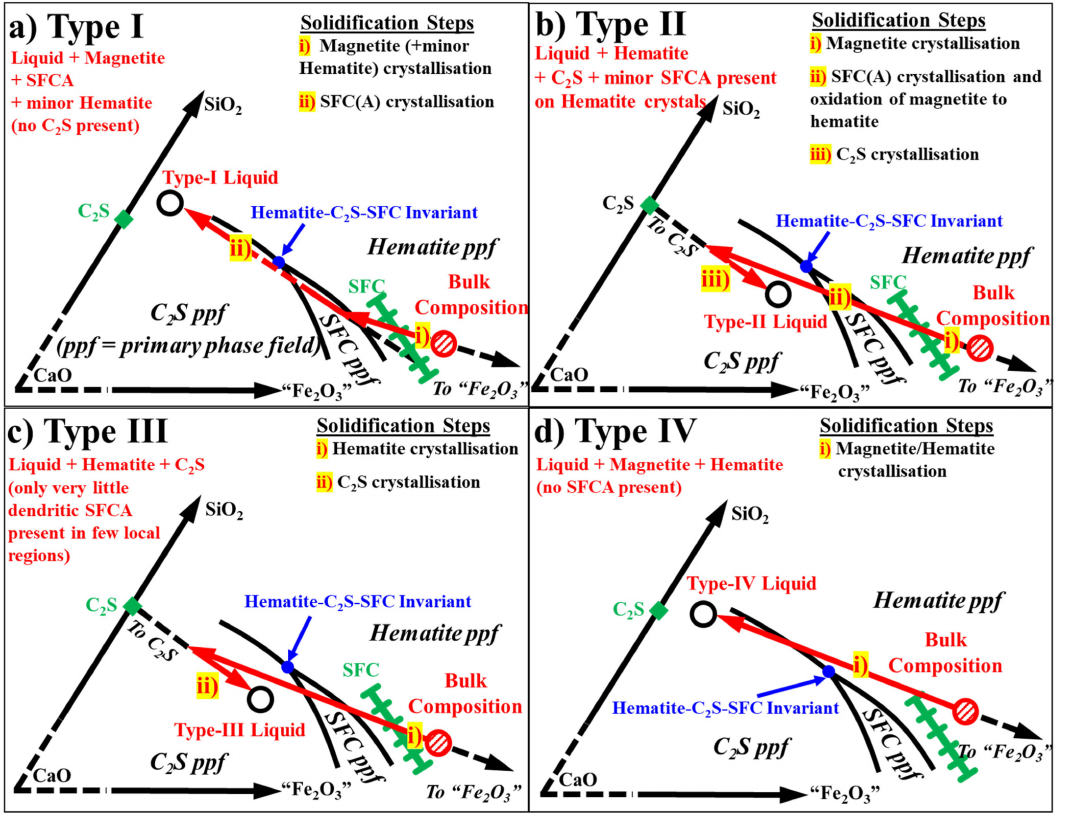
Figure 13. Schematic representation of changes in liquid composition during solidification in different Microstructure-Types, ( a ) Type I; ( b ) Type II; ( c ) Type III, and ( d ) Type IV in the